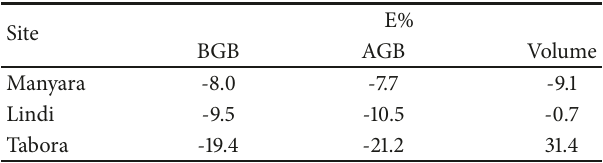
Table 8: Performance of regional AGB, BGB, and volume models for study